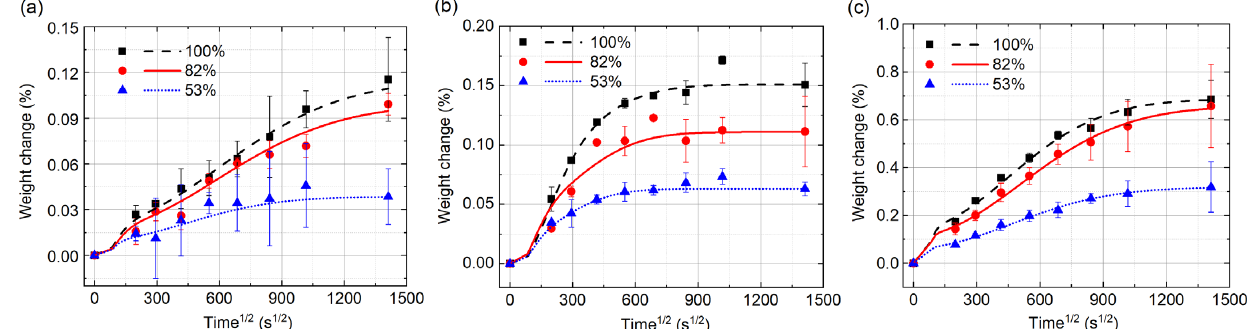
Figure 4. Weight changes of the samples under different environment humidities at 40 °C. ( a ) Type I; ( b ) Type II; ( c ) Type III.